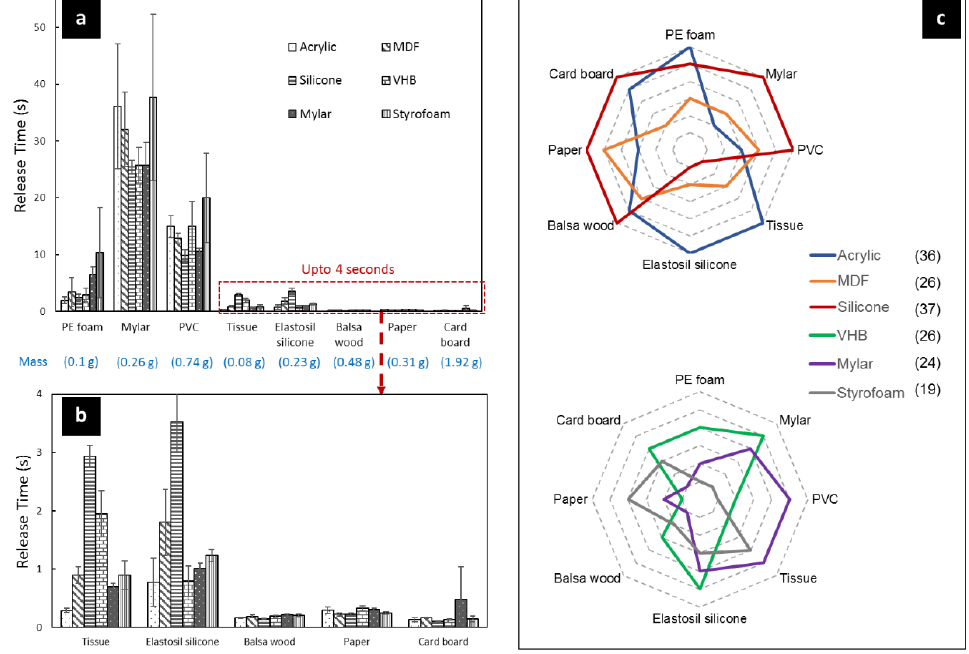
Figure 4. ( a ) Comparison of the release time six EA pads on eight objects. ( b ) Expanded comparison of objects with release time less than 4 s. ( c ) Performance scores of six EA pads based on the release speed of the eight objects.